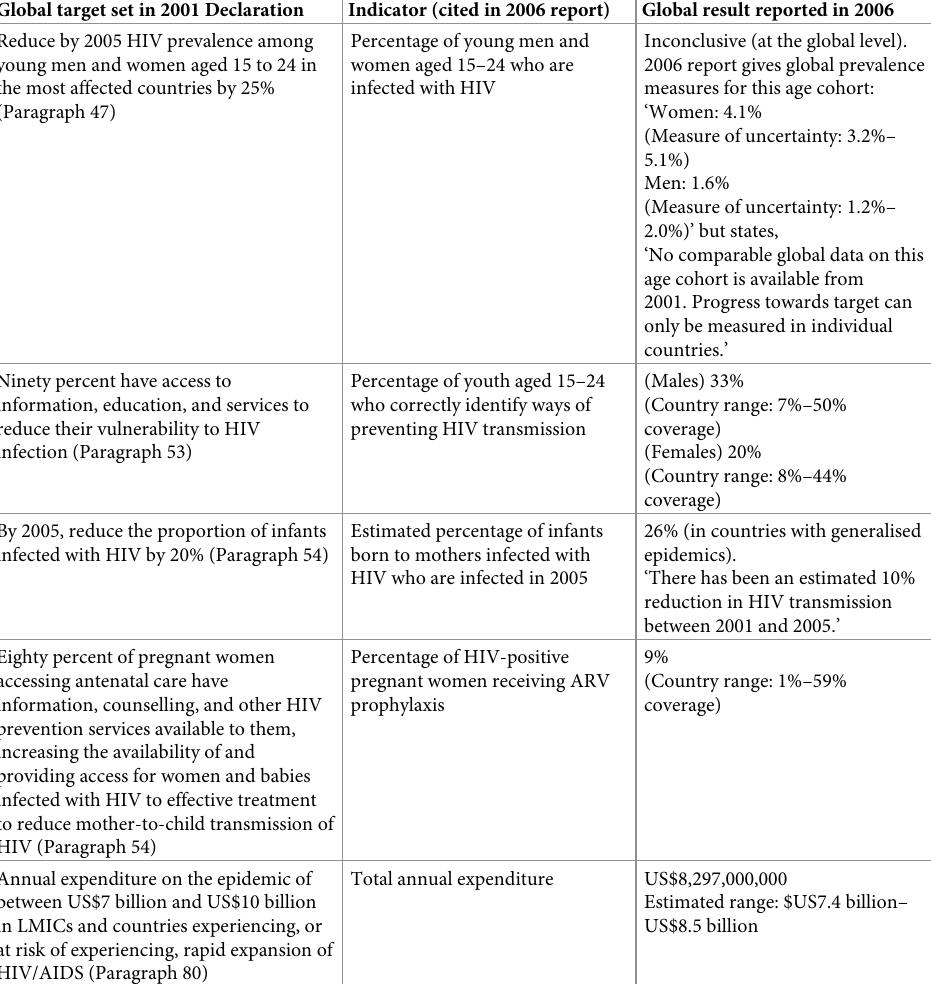
Table 3. Targets set in the UNGASS 2001 declaration of commitment on